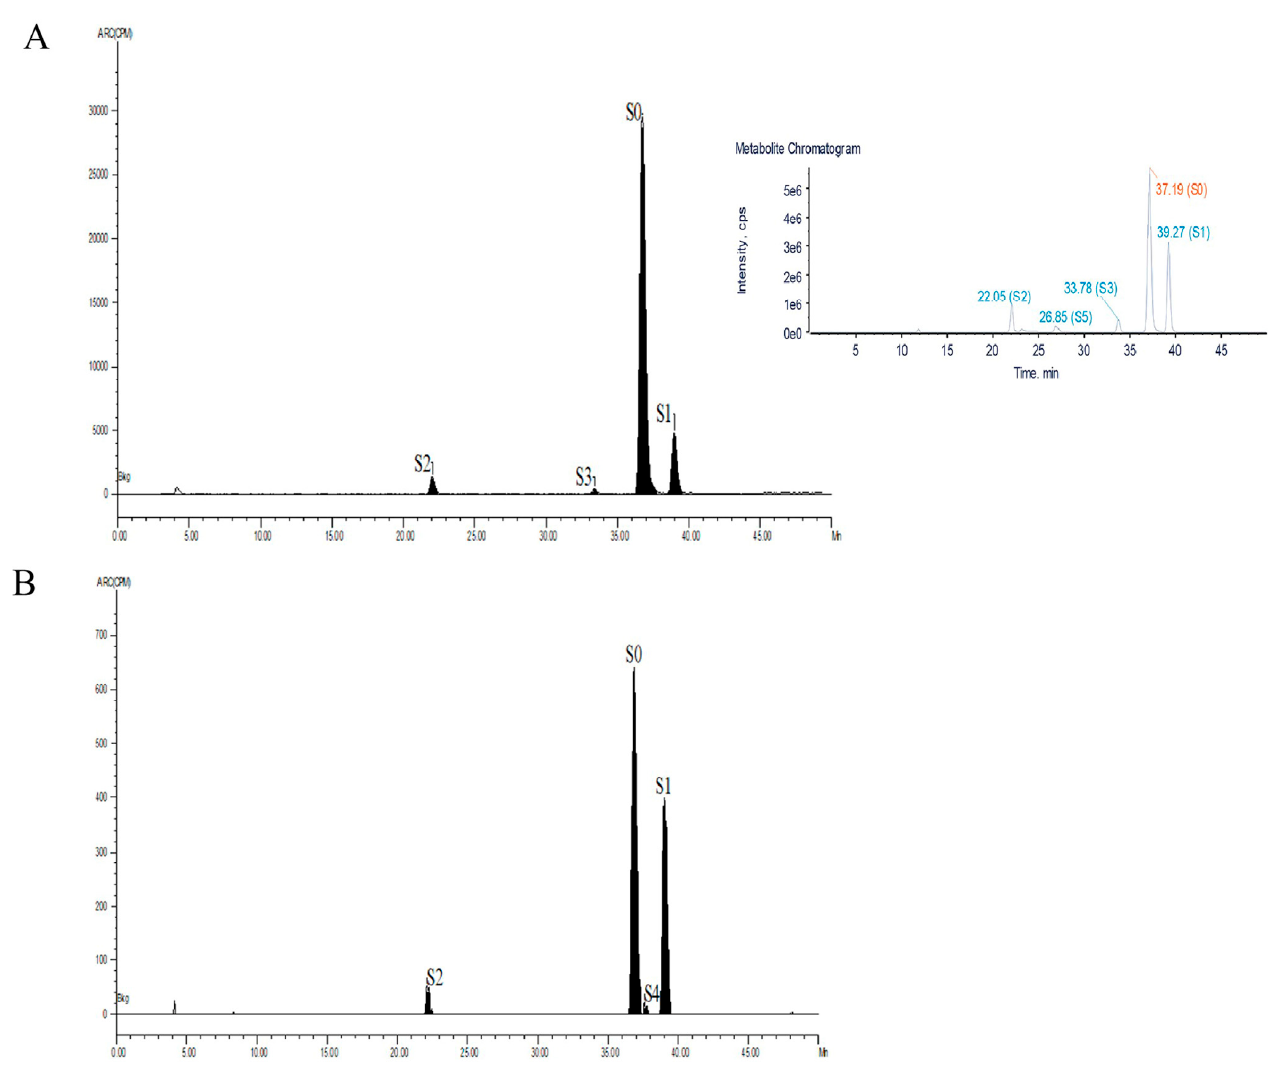
Figure 4. Radiochromatogram and total EIC of SMZ and its metabolites in the feces of chickens at 0–0.5 d ( A ) and 0.5–1 d after administration of [ 3 H]-SMZ ( B ). S0, sulfamethoxazole; S1, N4-acetyl-sulfamethoxazole; S2, 5-hydroxysulfamethoxazole; S3, N4-hydroxysulfameth-oxazole; S4, N4-sulfatesulfamethoxazole; S5, N4-glucuronidsulfamethoxazole.